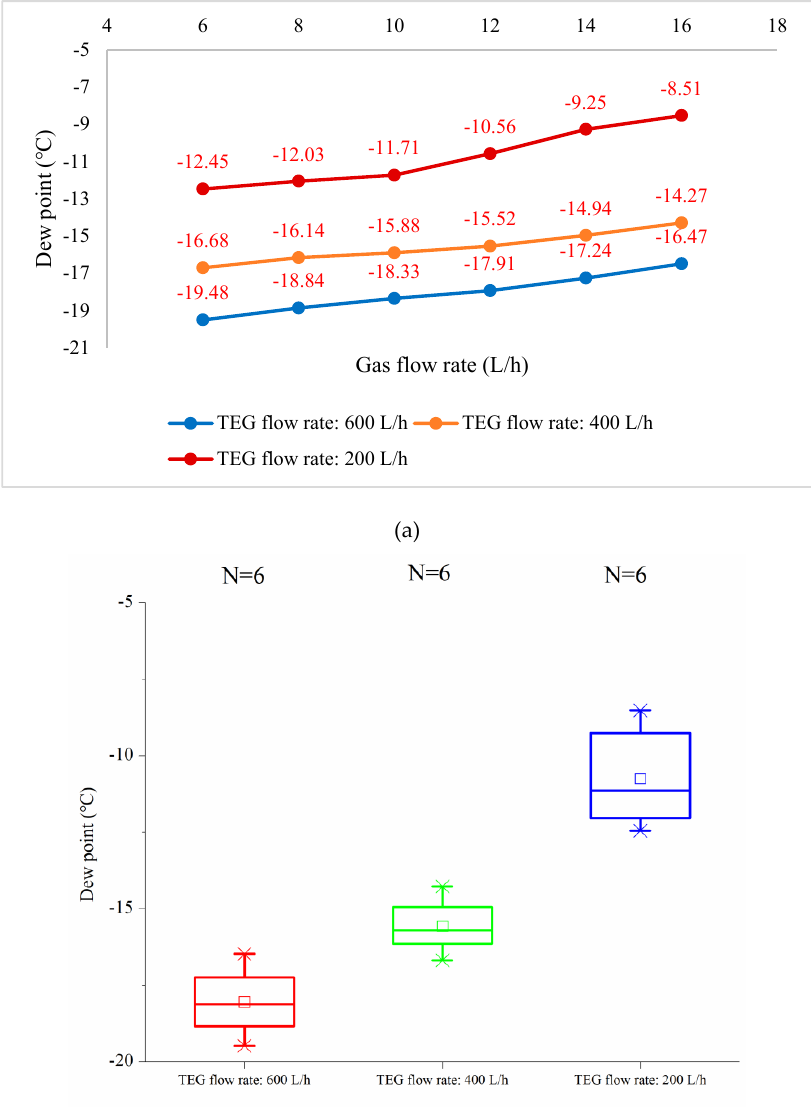
Figure 7. Effect of gas flow rate on dew point. ( a ) Experimental data; ( b ) Box-plot. Figure 7. E ff ect of gas flow rate on dew point. ( a ) Experimental data; ( b )